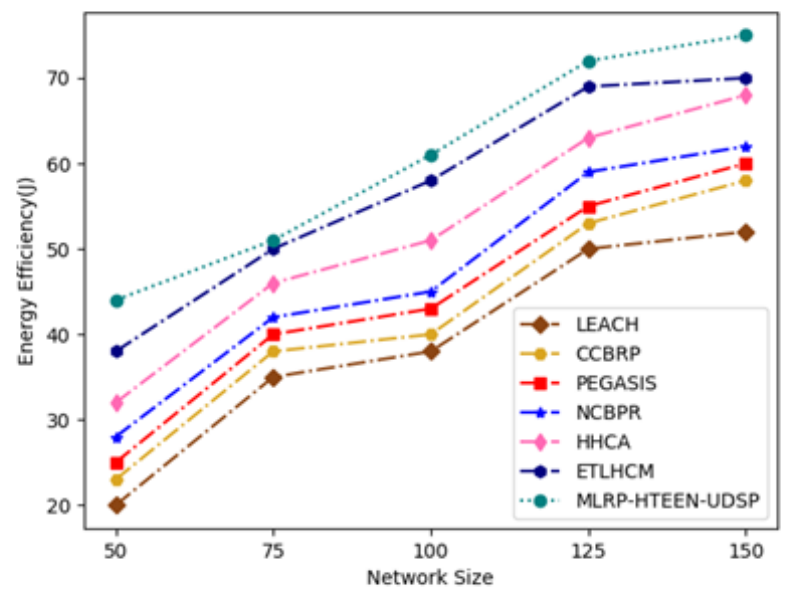
Figure 8. Comparison of energy efficiency.